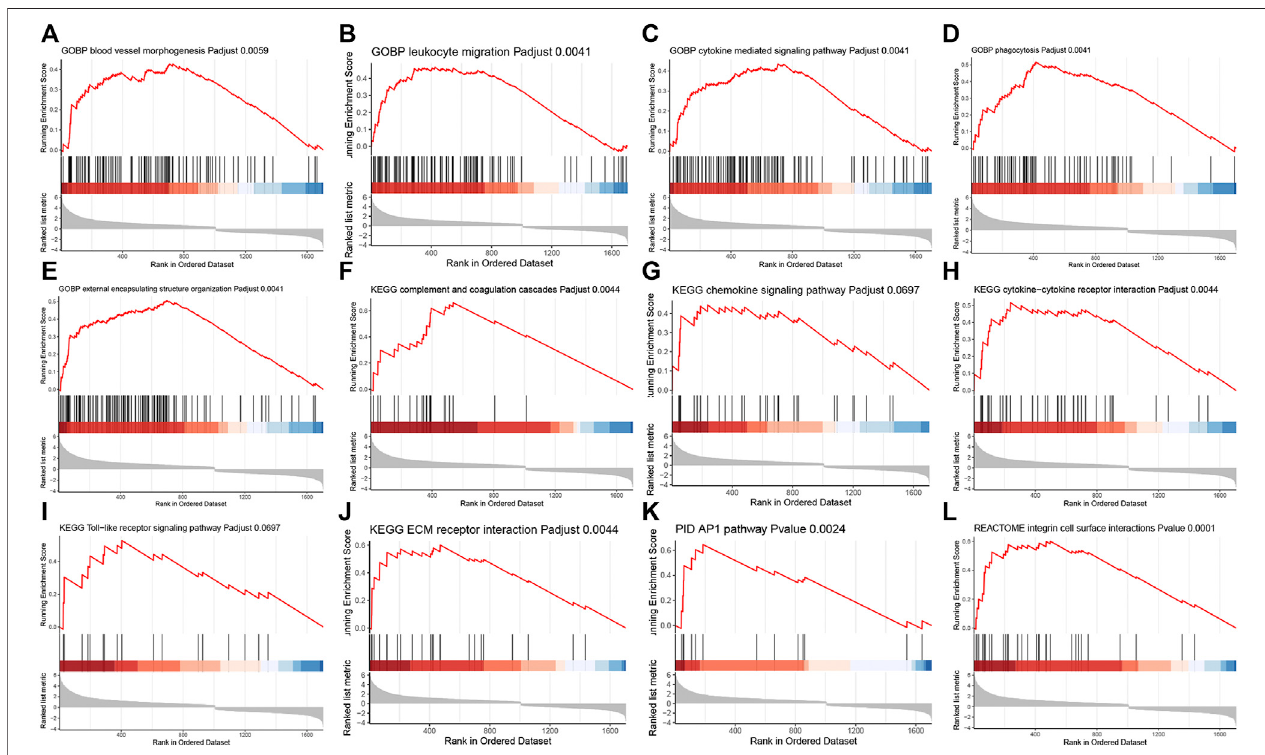
FIGURE 4 | GSEA analysis revealed related biological processes and signaling pathways enriched in the FBR induced by silicone implants. (A) Blood vessel morphogenesis. (B) Leukocyte migration. (C) Cytokine mediated signaling pathway. (D) Phagocytosis. (E) External encapsulating structure organization. (F) Complement and coagulation cascades. (G) Chemokine signaling pathway. (H) Cytokine-cytokine receptor interaction. (I) Toll-like receptor signaling pathway. (J) ECM receptor interaction. (K) AP1 pathway. (L) Integrin cell surface interactions.